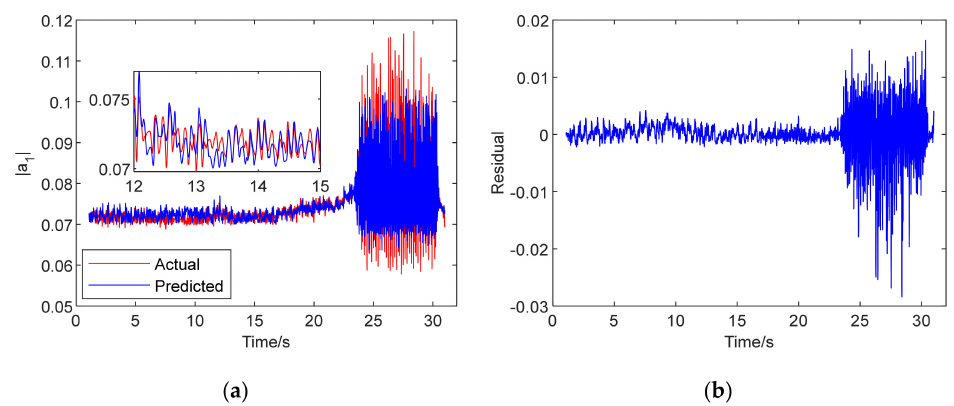
Figure 8. Result of Chaos–K-means–RBF neural network model: ( a ) prediction; ( b ) residual.